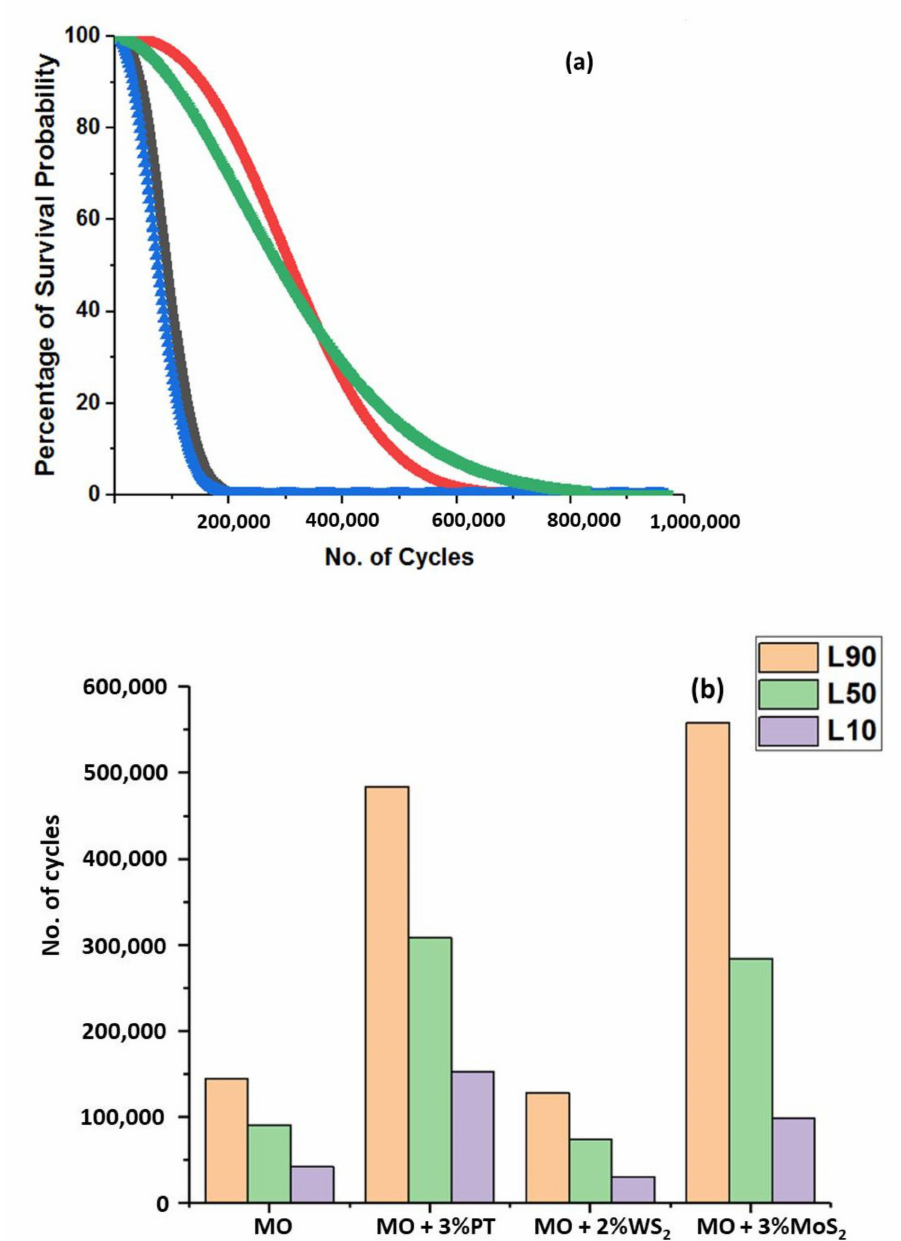
Figure 7. ( a ) Percentage of survival probability; ( b ) Life cycles in presence of lubricants with and without